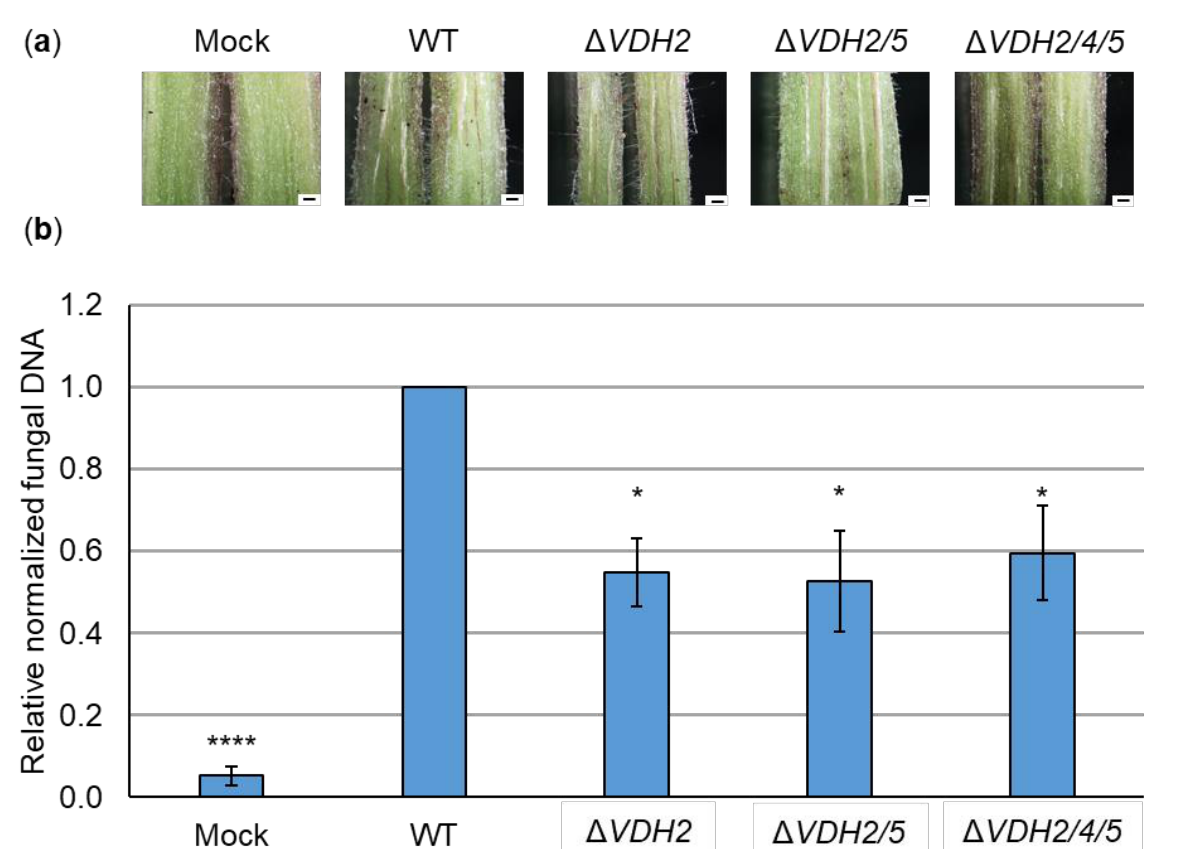
Figure 5. Infection by V. dahliae VDH2 deletion strains results in less fungal DNA detected in tomato hypocotyls than in wild-type-infected plants. Roots of ten-day-old tomato seedlings were immersed in water as a control (mock) or in spores of JR2 wild-type (WT), VDH2 single deletion ( ∆ VDH2 ), VDH2/5 double deletion ( ∆ VDH2/5 ), and VDH2/4/5 triple deletion ( ∆ VDH2/4/5 ) strains. Plants were incubated in a climate chamber at 16 h: 8 h light: dark at 22–25 ◦ C for 21 days. ( a ) Cross-sections of representative hypocotyls (scale = 500 µ m) are shown. Plants treated with wild-type and all deletion strains, but not mock-inoculated plants, exhibited discoloration of the hypocotyl. ( b ) Fungal DNA in hypocotyls was analyzed by quantitative PCR relative to plant DNA. Shown are the mean values of four biological replicates from three independent experiments. The error bars represent the standard errors of the mean. Significant differences from wild-type were calculated using Welch’s t -tests (*, p < 0.05; ****, p < 0.0001). Detected fungal DNA was reduced to about 60% of wild-type levels in plants inoculated with hydrophobin gene deletion strains.